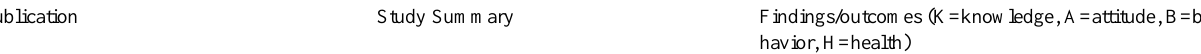
Table 3. Summary of sexual health reviews.